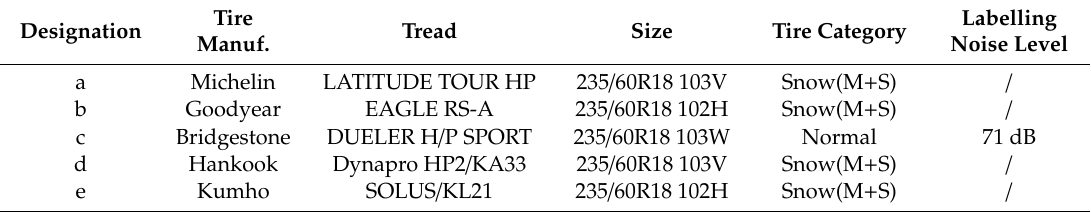
Table 1. Parameters of experimental tires.